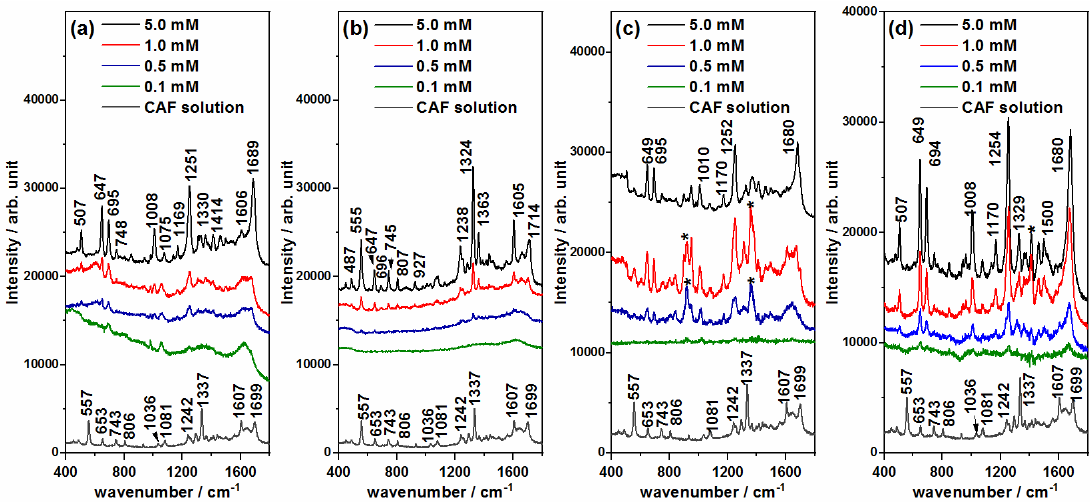
Figure 5. SERS spectra of caffeine (CAF) recorded at different concentrations using ( a ) Ag@BH, ( b ) Ag@HX, ( c ) Ag@Citr and ( d ) Ag@βCD3 NPs. Raman spectrum of 0.1 M aqueous solution at the bottom. Colloidal bands after subtraction are marked with (*).